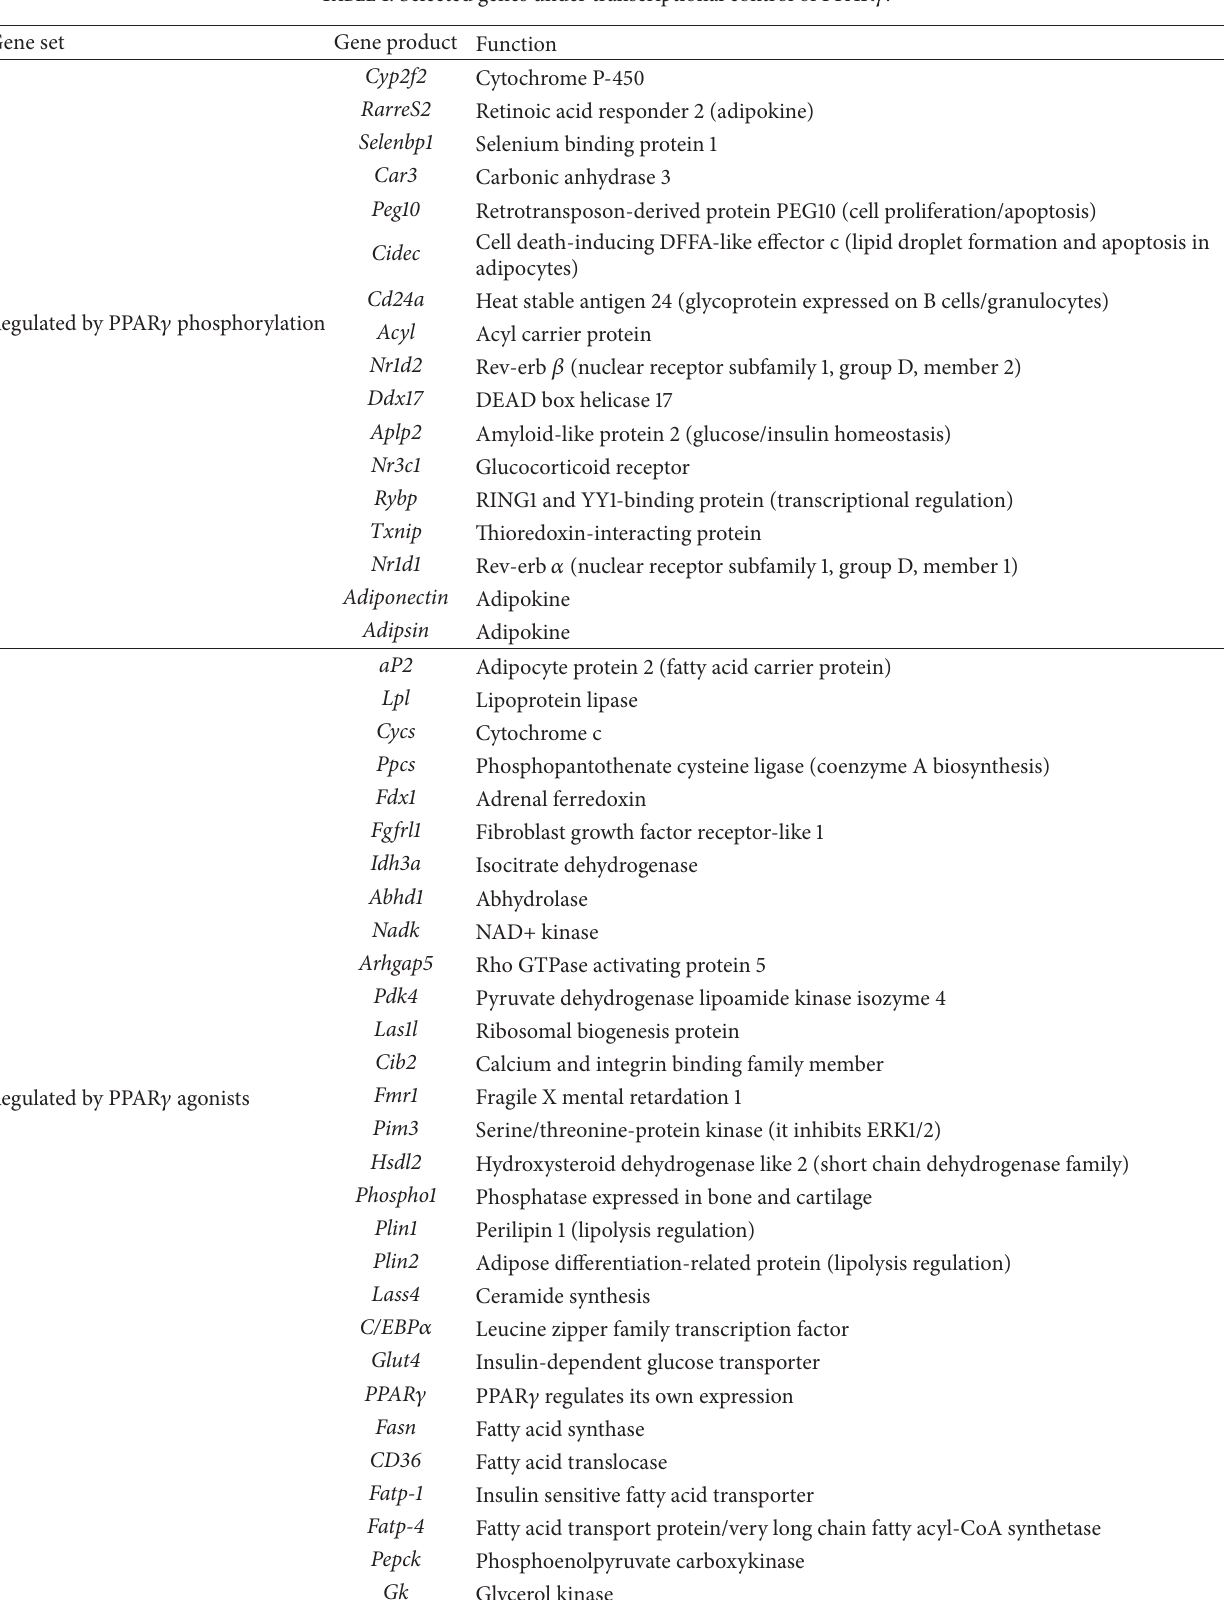
Table 1: Selected genes under transcriptional control of PPAR 𝛾